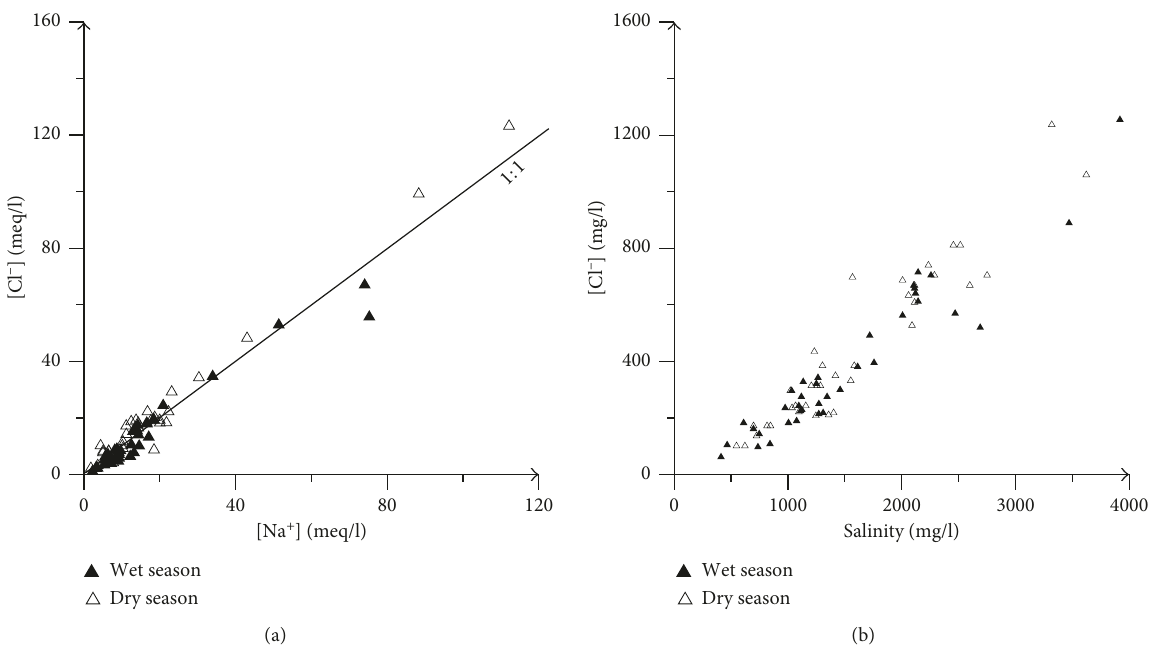
Figure 6: Bivariate pot of (a) Na + versus Cl − and (b) salinity versus Cl − .